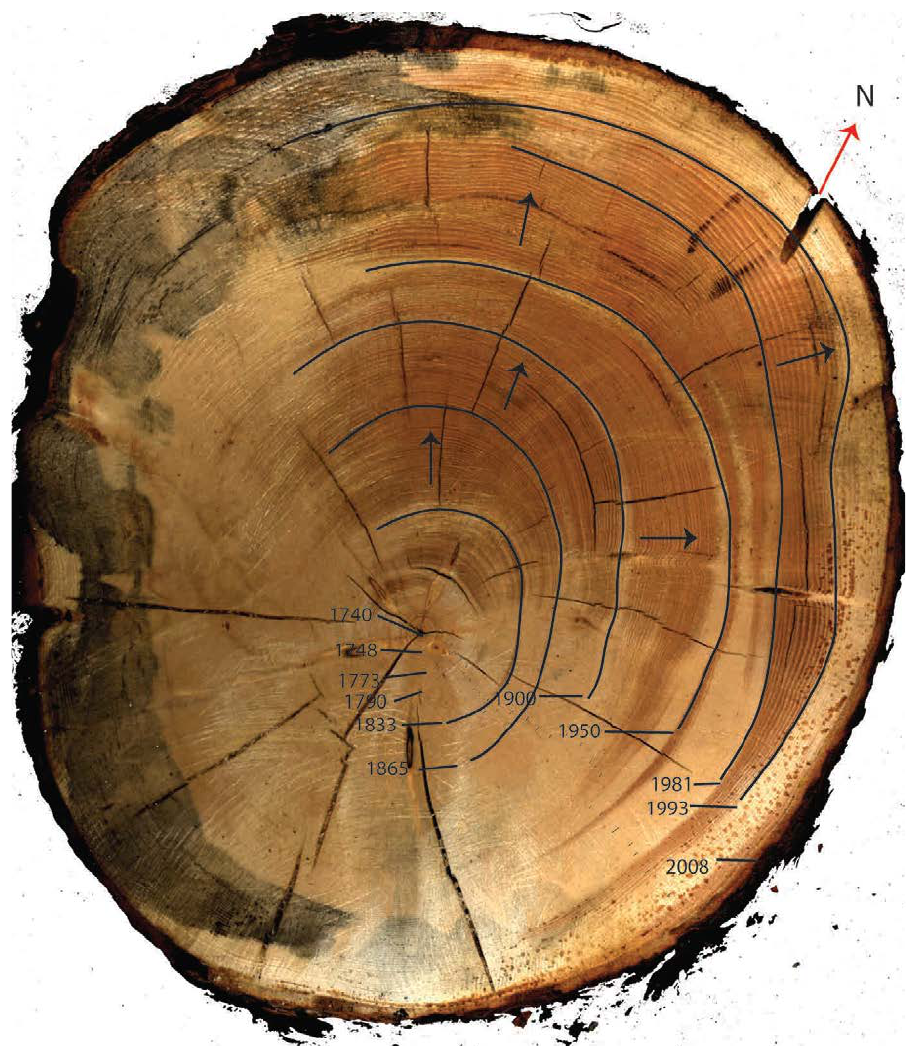
Figure 9. Tree rings with compression wood direction shifts. The tree was harvested in 2008. Changes in the direction of compression wood growth (indicated by black arrows) occurred in the years indicated in the figure.